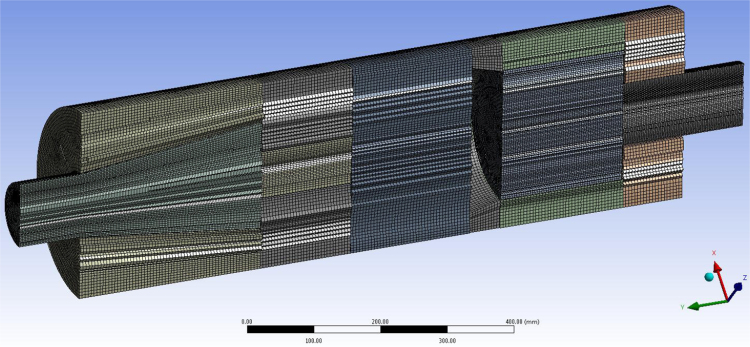
Computational mesh.